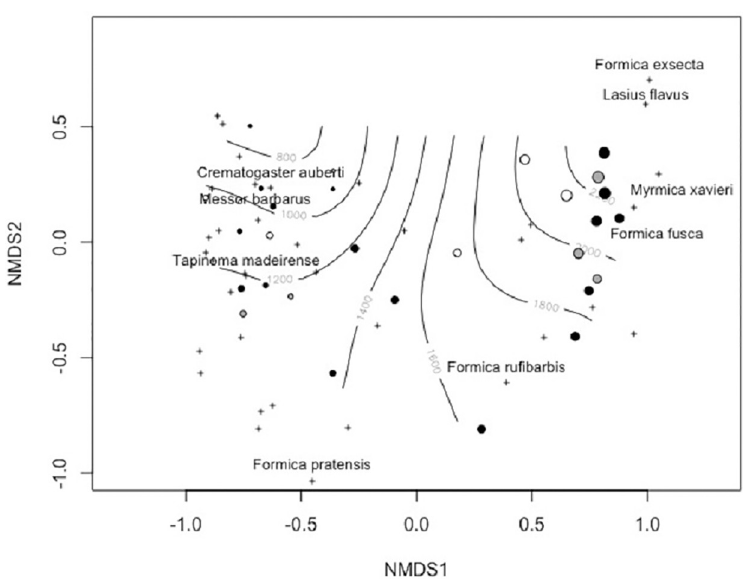
Fig 3. Non-metric multidimensional scaling (NMDS) of ant assemblages based on binary Bray-Curtis distances among grasslands calculated with species occurrences from pitfall traps in a Mediterranean range of central Spain. Circles represent data from Guadarrama (black: year 2014, grey: year 2015) and Serrota (open circles) ranges. Symbol sizes are proportional to the elevation of sampling plots. As reference, circles are superimposed to a smooth elevation surface (estimated using a GAM of elevation on a bivariate spline of NMDS scores). The positions of some illustrative species are given as reference.